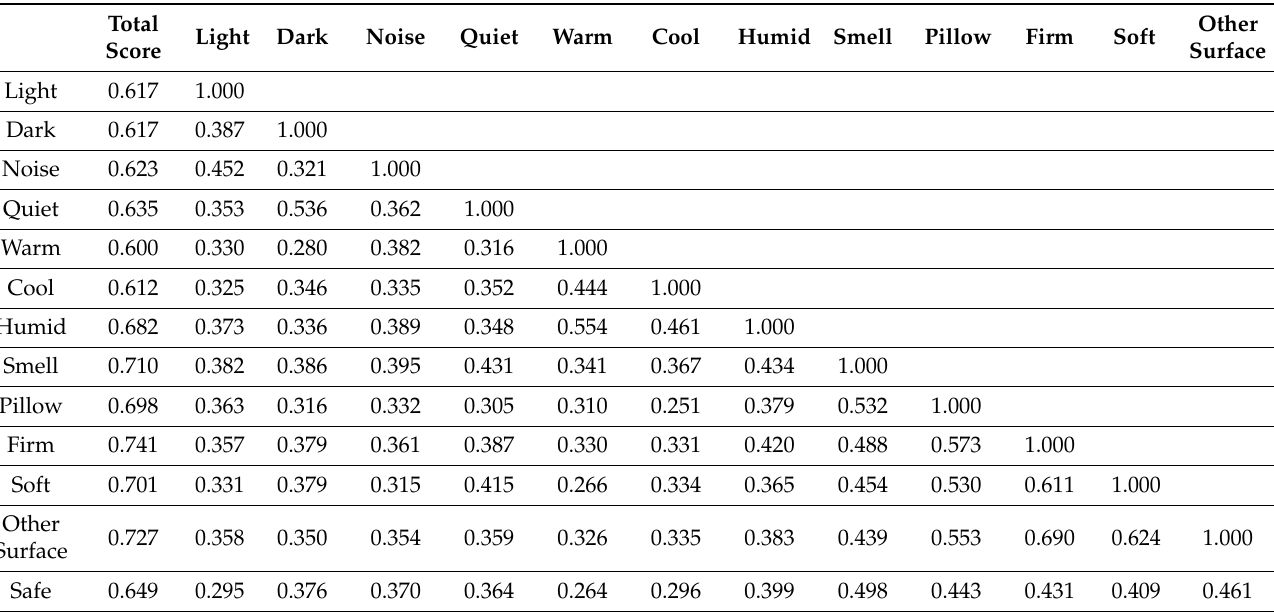
Table 2. Correlations Among ASE Items (all p <